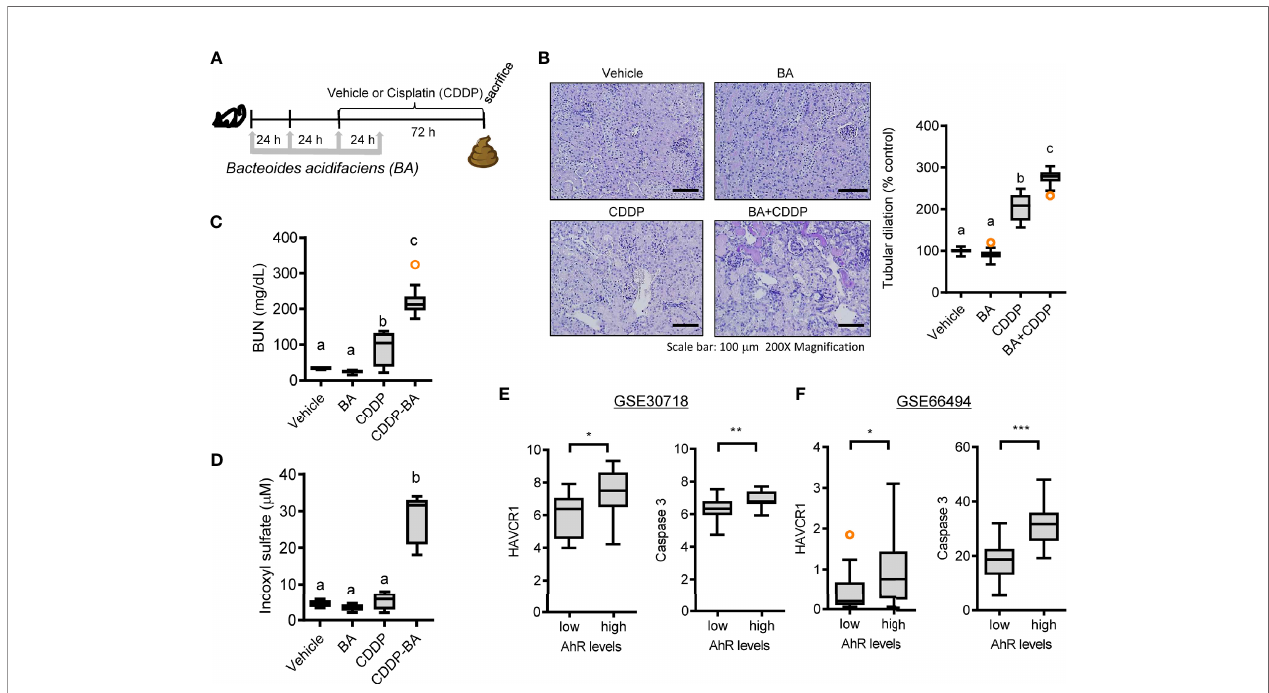
FIGURE 7 | Effects of STR exposure on IS production and disease outcomes during renal injury. (A) Eight-week-old wild type male mice (n = 3 – 5) were daily preexposed to the vehicle or 5x10 9 cfu/mL of Bacteroide acidifaciens in phosphate-buffered saline via oral gavage for 4 days. On the third day of microbial exposure, renal injury was induced with CDDP (20 mg/kg) via intraperitoneal administration for an additional 72 h. (B) PAS staining (the left panel) and tubular dilation levels according to PAS staining (the right graph). (C) levels of blood urea nitrogen (BUN). (D) The blood indoxyl sulfate levels were measured using high-performance liquid chromatography. Results are representative of two independent experiments. The results are shown as a plot with Tukey whiskers and the different letters (a – c) over each box represent signi fi cant differences between groups using ANOVA with Newman – Keuls method as a post hoc ANOVA assessment (p<0.05). (E, F) Expression of renal injury biomarker genes was assessed in patients with acute kidney injury (gse30718, n = 47, E ) or chronic kidney disease (gse66494, n = 61, F ). Results are shown in a box plot with Tukey whiskers and the asterisks ( ∗ ) indicate signi fi cant differences between two groups using Student ’ s t-test (*p < 0.05, **p < 0.01, ***p <